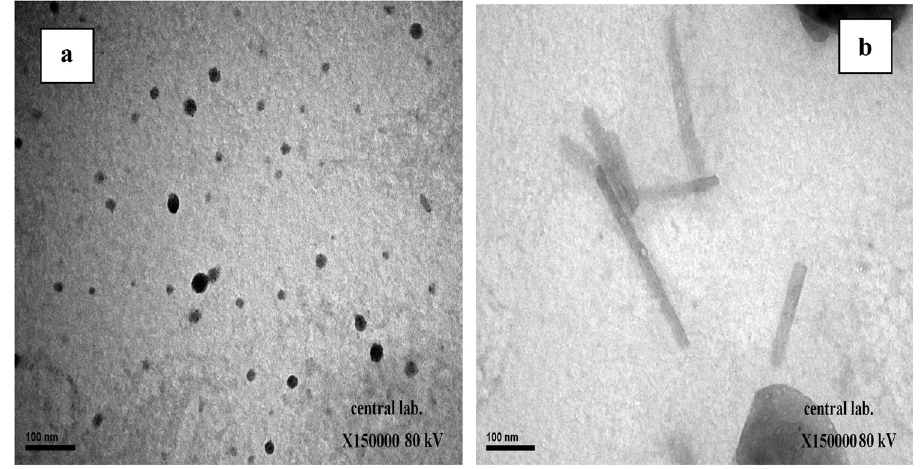
Figure 3: ( a and b ) TEM images of lupin TiO 2